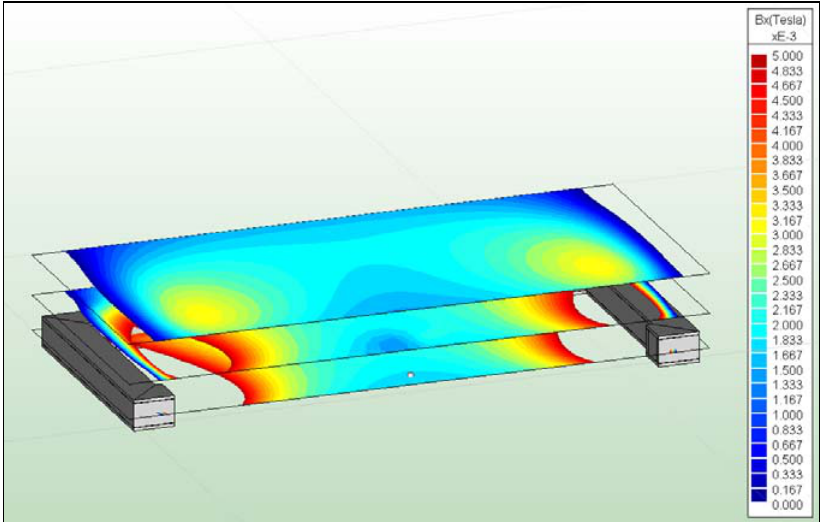
in three different planes of the magnetic ex = 2.24 c